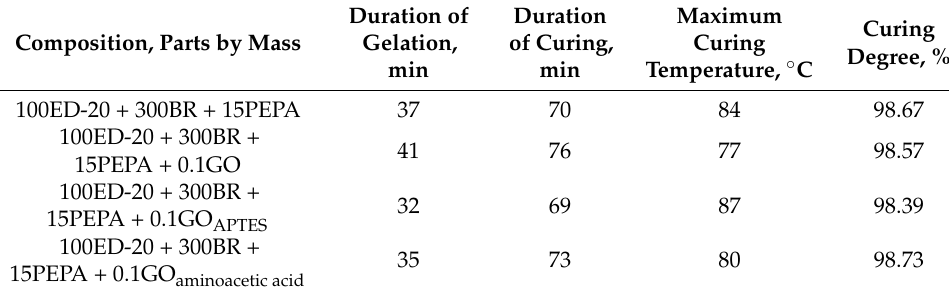
Table 2. Values of indicators of epoxy composition curing.